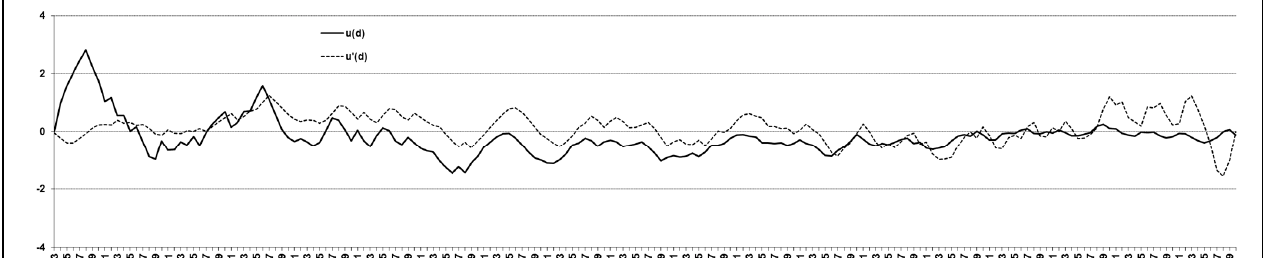
Figure 5. Graphical representation of sequential Mann-Kendall test for the annual standardized tree-ring time series in Pertouli, with forward trend u(d) (solid line) and backward trend u’(d) (dashed line) at the 0.05 confidence level.